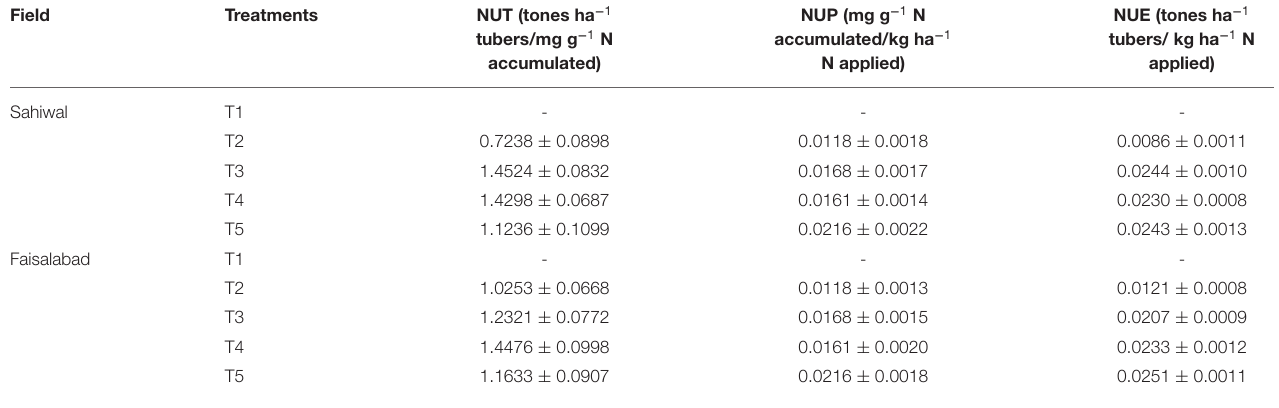
TABLE 5 | Effect of Azospirillum inoculation and varying doses of N fertilizers on NUT, NUE and NUP.